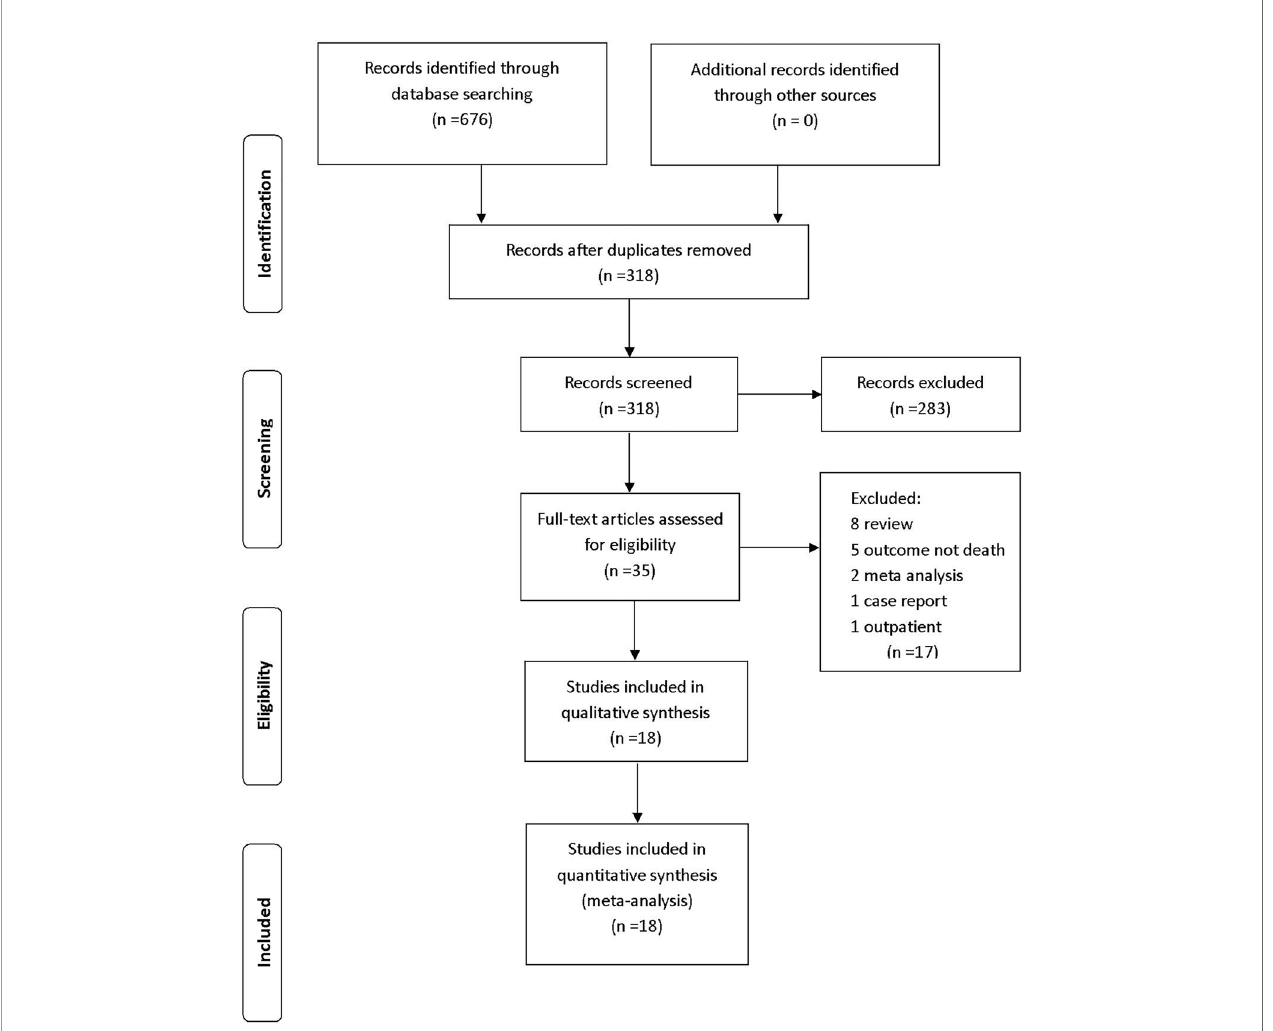
FIGURE 1 | PRISMA